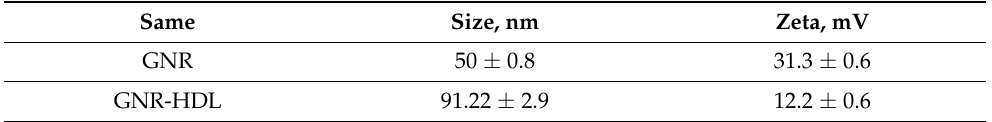
Table 2. Zeta potential and dynamic light scattering size measurements of bare GNRs and HDL coated GNRs. The significant difference that was obtained (by zeta potential, DLS and UV-vis spectroscopy) following coating demonstrates the efficiency of the chemical coating.